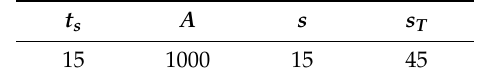
Table 2. Theoretical values s T for 15 s of sampling time and 1000 ms of advertising interval.